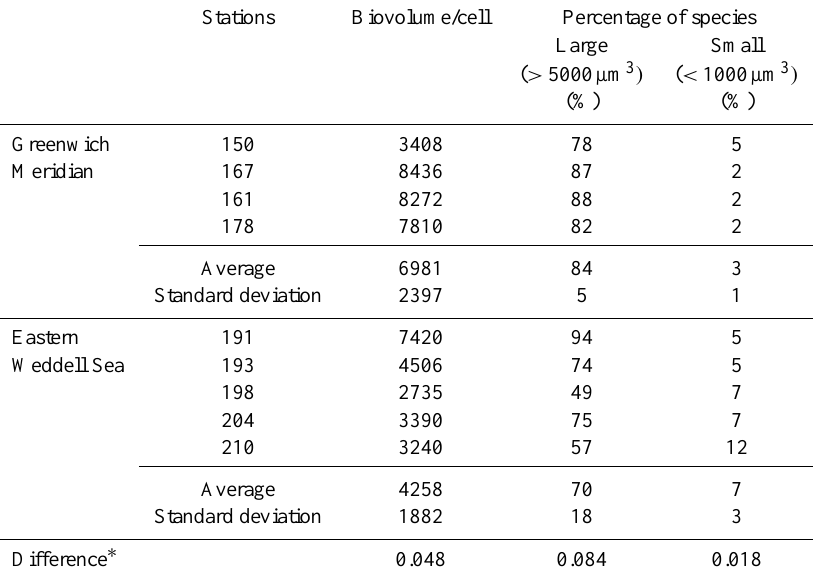
Table 1. Size and volume of diatom species at the zero meridian and eastern Weddell Sea